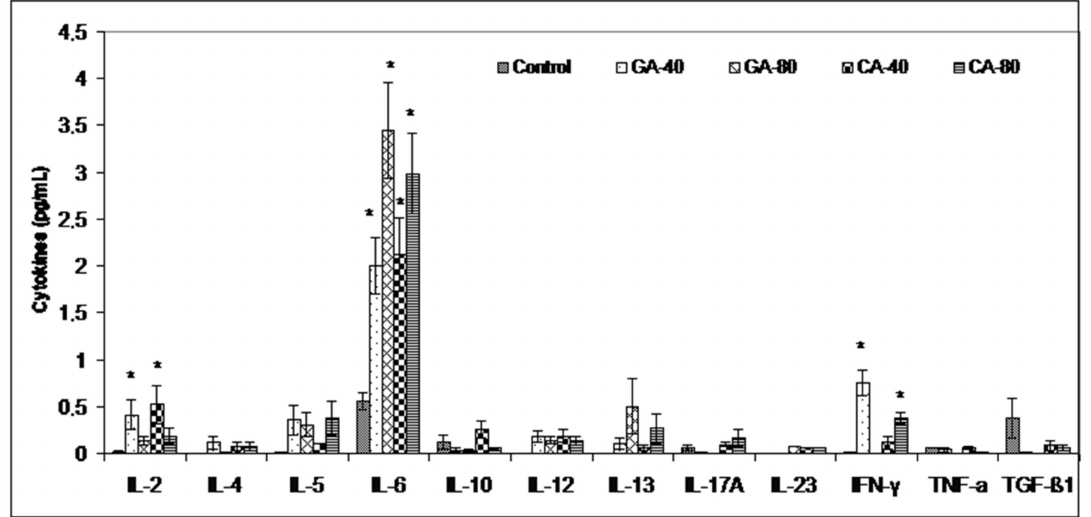
Figure 7. E ff ect of GA and CA on Th1, Th2, and Th17 cytokines in the ascites fluid of mice bearing EAT. Mice were injected intraperitoneally ( ip ) with 2.5 × 10 6 viable EAT cells and treated with GA or CA at a dose of 40 mg / kg and 80 mg / kg ip in exponential tumor growth phase on days 5, 7, 9, and 11. Mice were sacrificed on the 13th day, ascitic fluid was collected, and cytokine levels were estimated by ELISA. The results are expressed as the mean value of each experimental group ± SE of the mean of three di ff erent observations; * p < 0.05 as compared to the control group treated with saline. Abbreviations: EAT, Ehrlich ascites tumor; GA, gallic acid; CA, ca ff eic